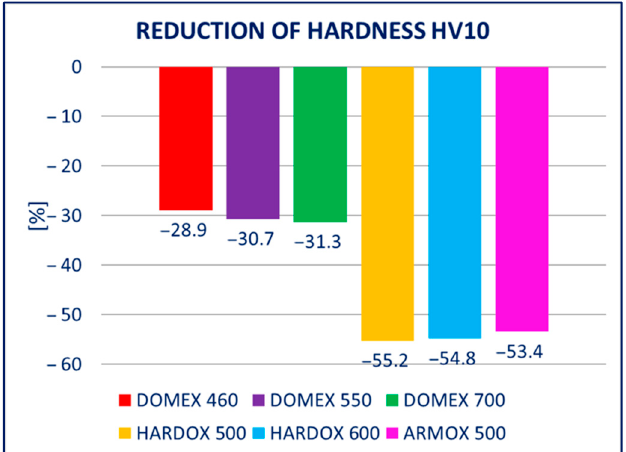
Figure 19. Summary of the results for hardness tests presented in the Results section: relative change in hardness for the different types of steels.